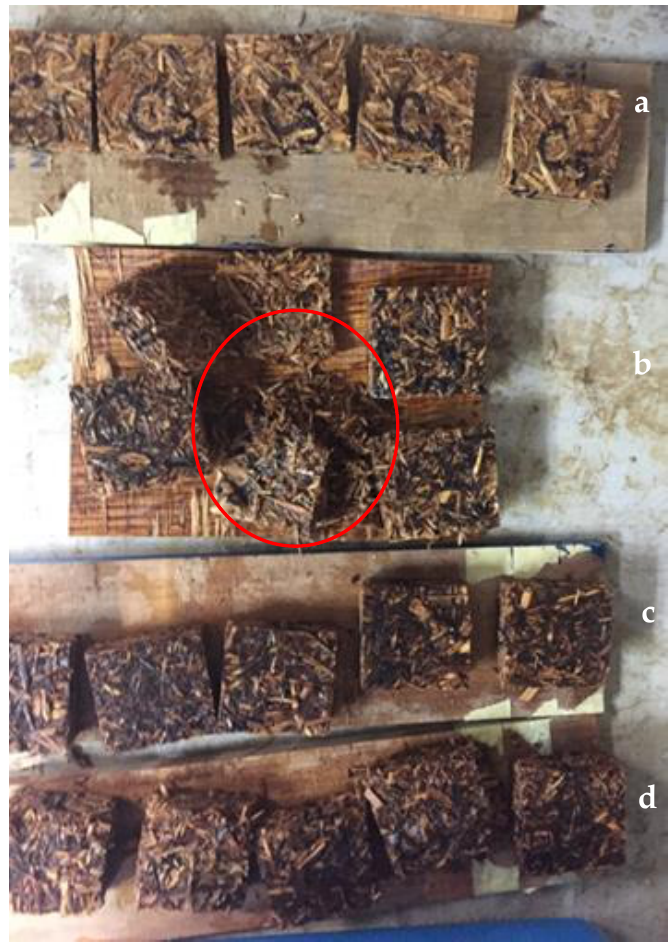
Figure 2. Visual appearance of particleboards after 24 h immersion in water; ( a ) control, ( b ) 10 wt% citric acid, ( c ) 15 wt% citric acid and ( d ) 20 wt% citric acid, where disintegration of particleboard (red circle) was noticed.